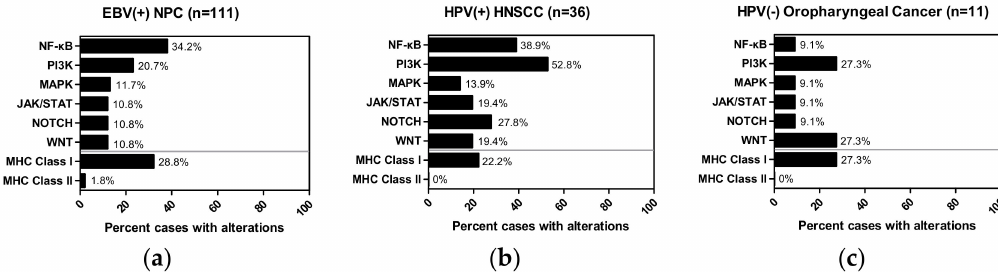
Figure 1. Bar graphs showing percentage of tumors harboring somatic mutations of 6 major signaling pathways (NF- κ B, PI3K, JAK/STAT, MAPK, NOTCH, WNT), and of the MHC Class I, and MHC Class II genes in ( a ) EBV(+) NPC cohort ( n = 111), ( b ) HPV(+) HNSCC cohort ( n = 36; TCGA) and ( c ) HPV( − ) oropharyngeal cancer cohort ( n = 11; TCGA). The NF- κ B pathway is defined as TAB1/2/3 , MAP3K7/14 , CHUK , IKBKB , IKBKG , NFKBIA , NFKBIE , REL , RELA/B , NFKB1/2 , LTBR , TNF ,